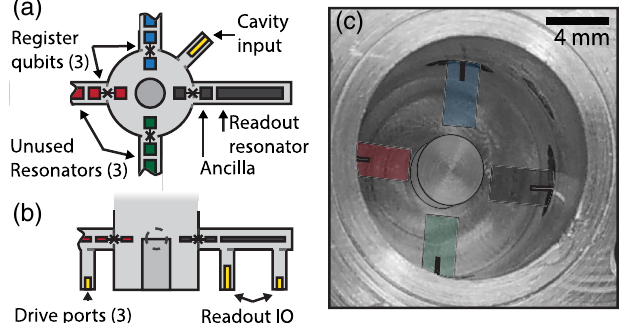
FIG. 1. The experimental sample consists of a central λ = 4 stub resonator [33], machined out of 6061 aluminum, with a lifetime of 72 μ s, consistent with our expectation of the limitation due to surface losses. Four sapphire chips enter the cavity radially, each of which supports a 3D transmon and a quasiplanar coaxial λ = 2 resonator [34], patterned in the same lithographic step. All four λ = 2 resonators have undercoupled input ports for fast individual qubit control. One resonator has a low- Q ( 1 = κ ¼ 60 ns) output port that leads to a Josephson parametric converter (JPC) [3]. This enables high-fidelity (98%) readout of the directly coupled qubit, which we designate as the ancilla. The other three qubits are designated as the register, and their associated three resonators are unused. All qubits share essentially identical capacitive geometry, but differing Josephson energies space the qubits by roughly 400 MHz. This results in dispersive shifts f χ i g ¼ f 1 . 651 ; 1 . 194 ; 0 . 811 ; 0 . 613 g MHz and f χ ij g generally on the order of 1 kHz. Further Hamiltonian and coherence details are in the Supplemental Material [32]. The cavity has an undercoupled input port, used for conditional and unconditional displacements, and a diagnostic output (which is also undercoupled and is not depicted). Panels (a) and (b) depict top view and side view schematics, respectively. Not to scale. (c) False-color top view of the physical device with outlines for